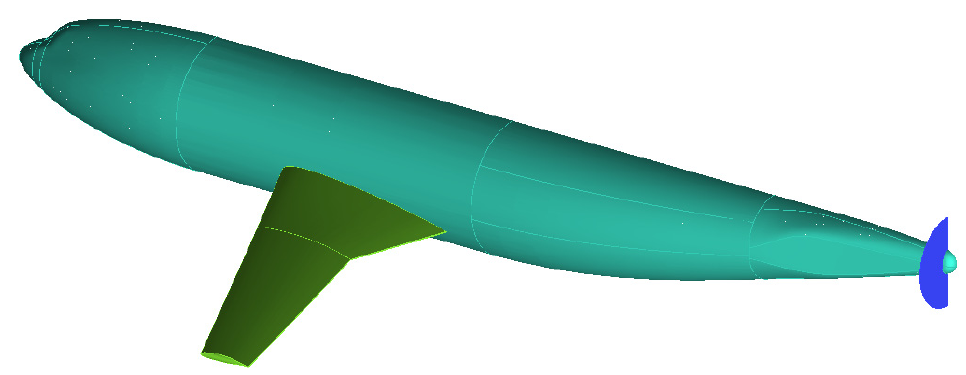
Figure 4. The geometry of the DLR-F6 wing body configuration and the BLI configuration (half model). Table 2. Specifications of DLR-F6 geometry (body wing and BLI configurations).